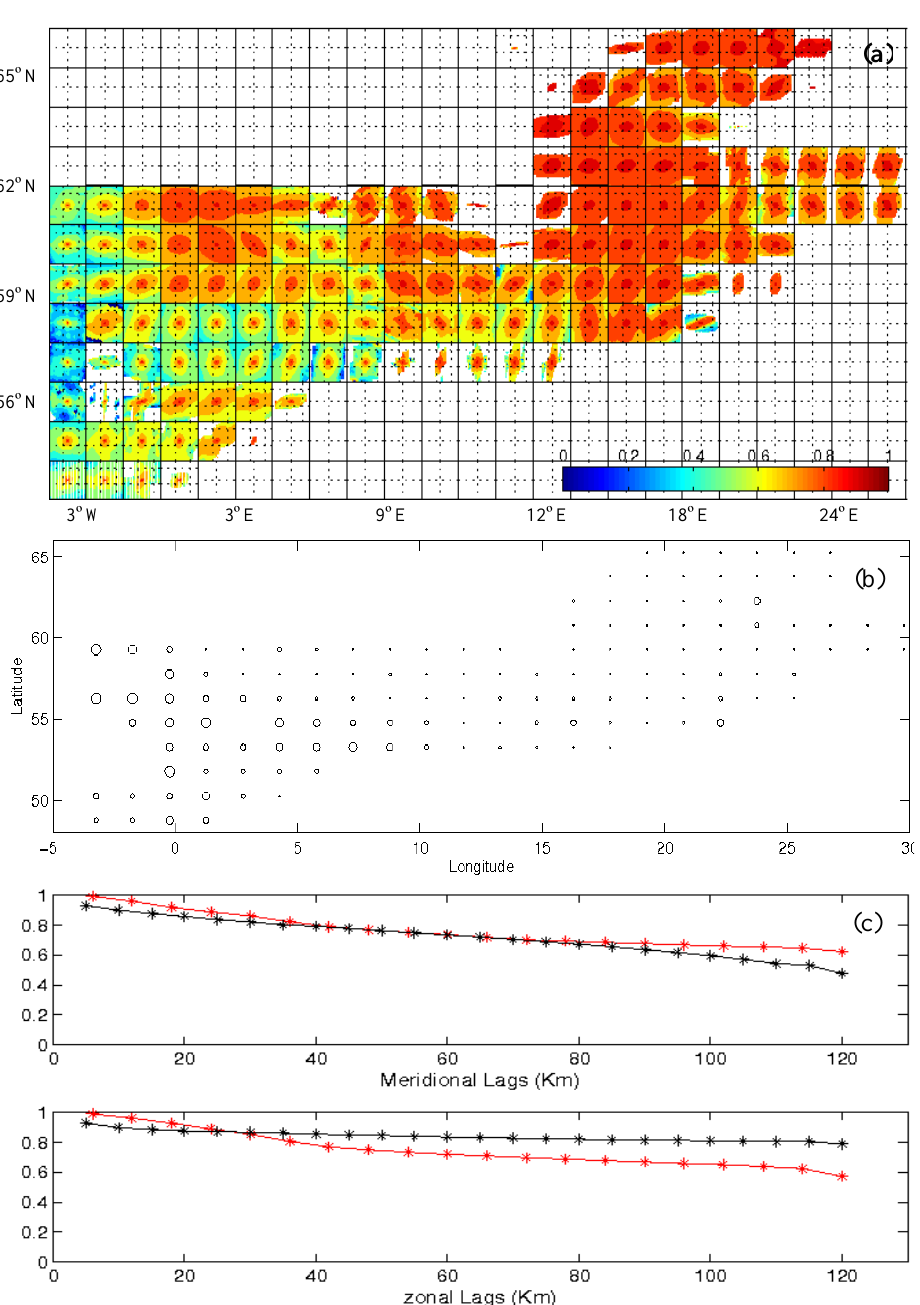
Figure 5, (a) contours of the spatial averaged correlations in 1.5 ° X1.5 ° bins calculated from the satellite SST; (b) differences of the total mean correlations for each bin between the proxy ocean and satellite data, size of the circles denotes magnitude of the differences, ranging from 0.01 to about 0.35. (c) the comparison of the correlations with meridional and zonal lags at (5.35 º E, 59 º N) from the proxy ocean data (red line) and the satellite data (black line).